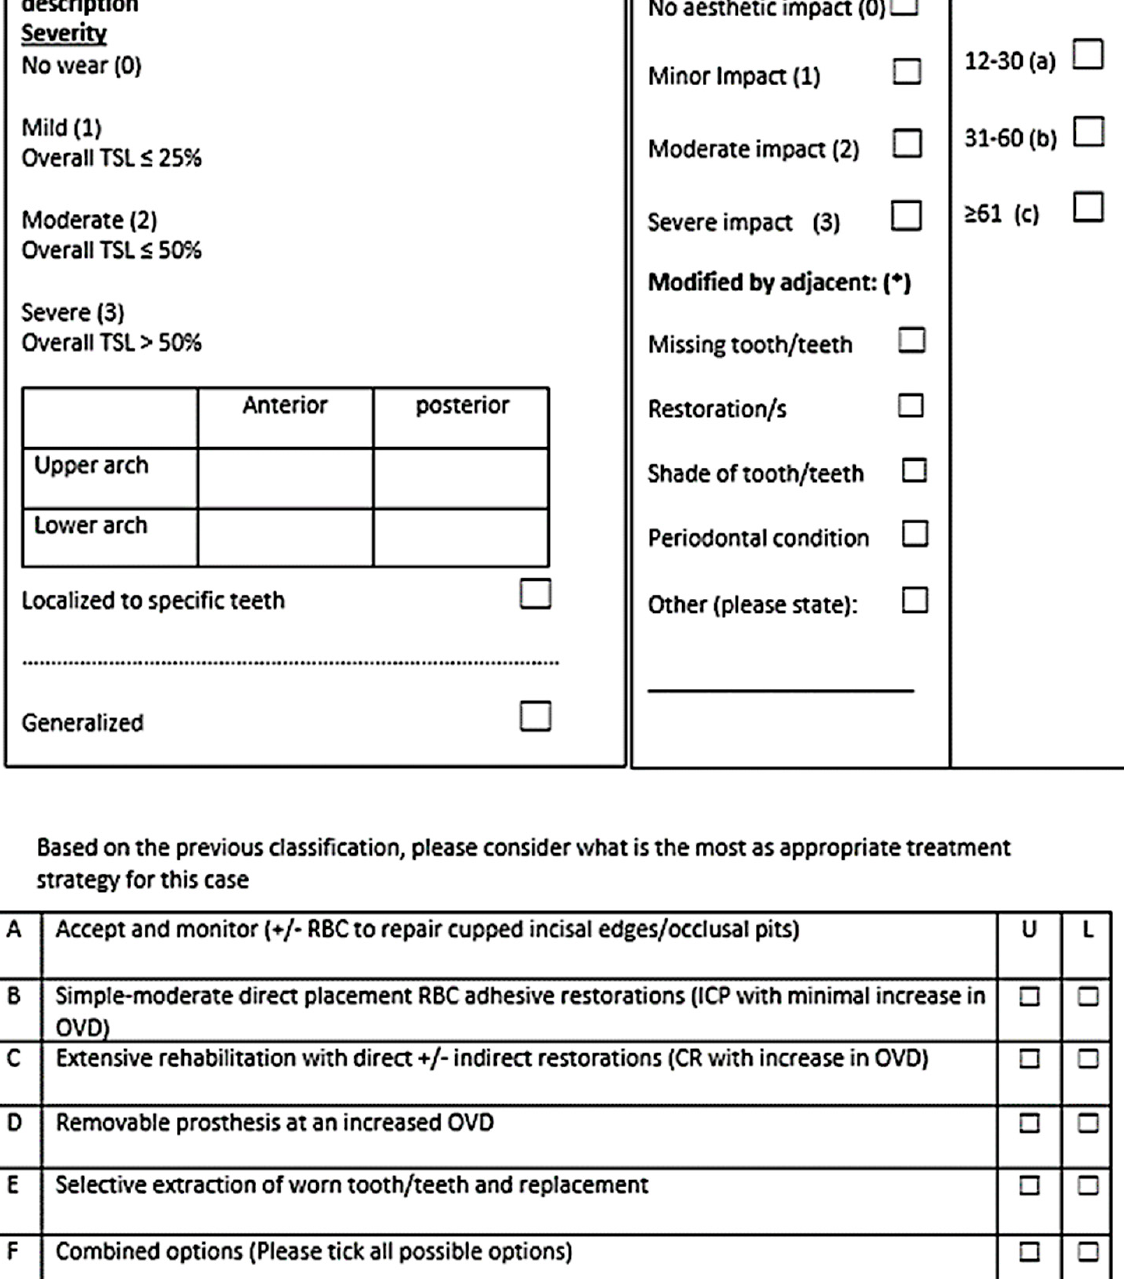
Figure 2. Classification tools for the main